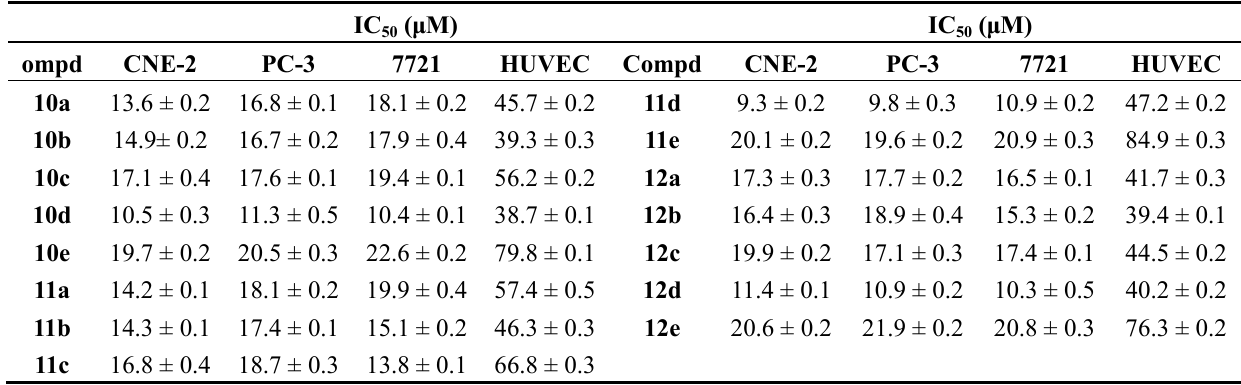
Table 1. IC cytotoxicity values (µM) of the quinazoline derivatives against tumor cells and 50